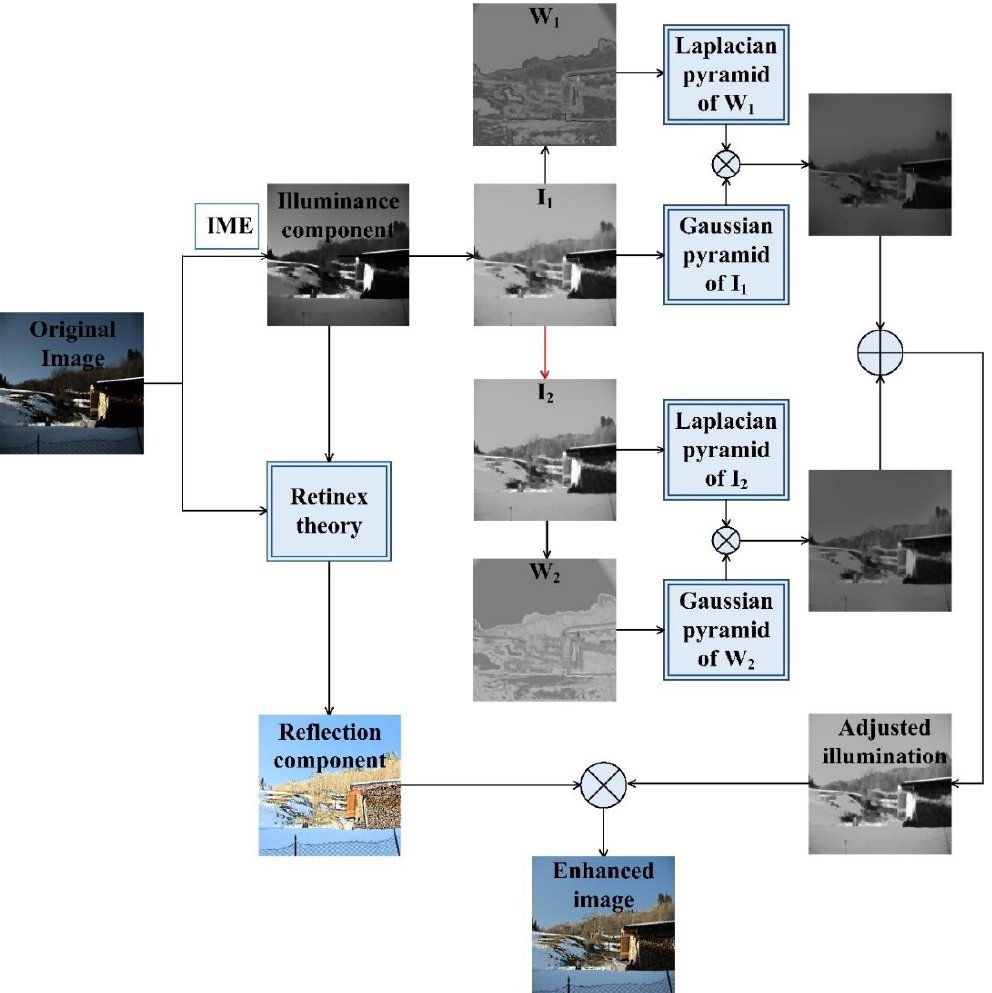
Figure 3. Flow chart of the algorithm for the proposed model.